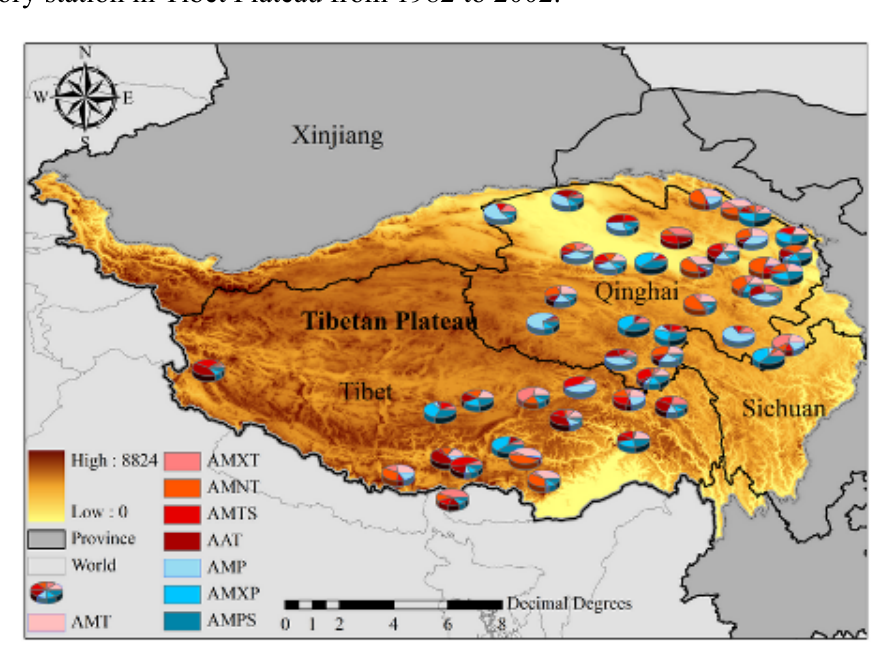
Figure 5. Percentage of coefficients between MNDVI and climatic factors based on each observatory station in Tibet Plateau from 1982 to